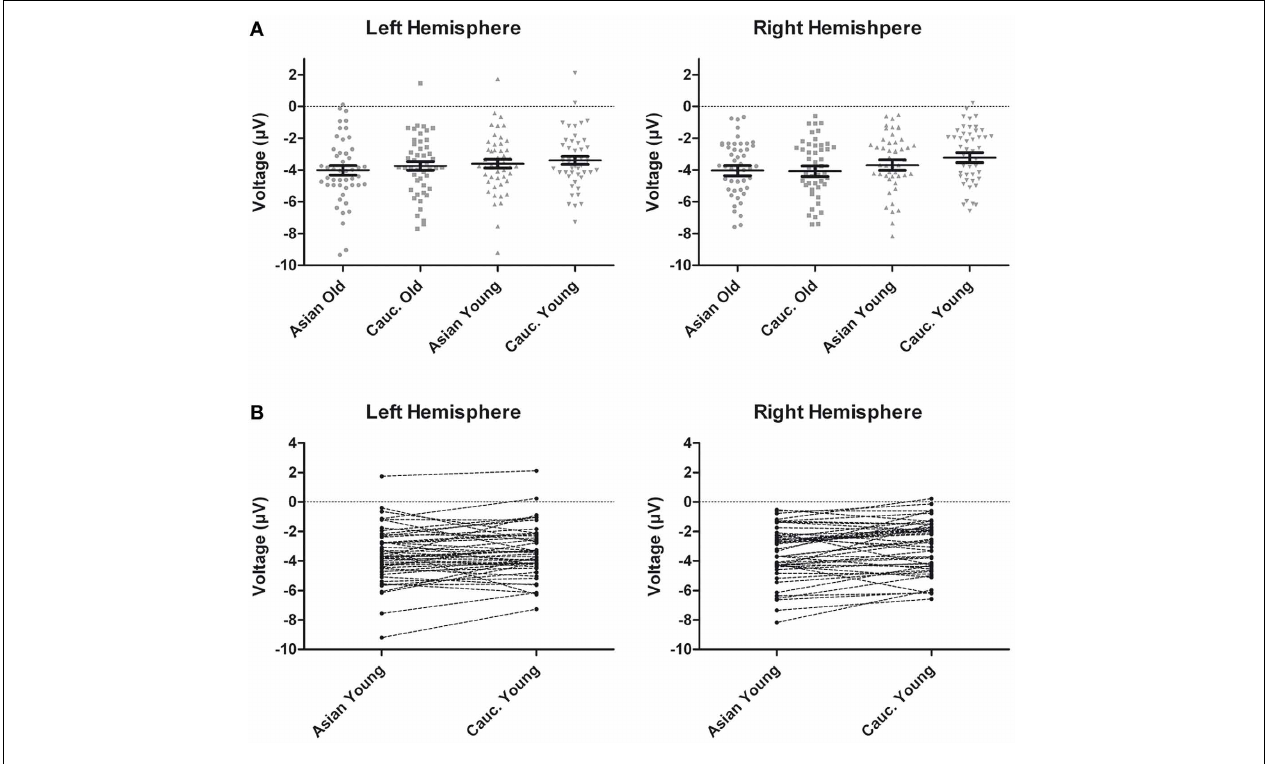
FIGURE 6 | (A) Scatter plots depicting ERP amplitudes in the 220–260ms time window averaged across left and right hemispheric occipito-temporal sites. Horizontal lines reflect mean amplitudes, error bars denote standard